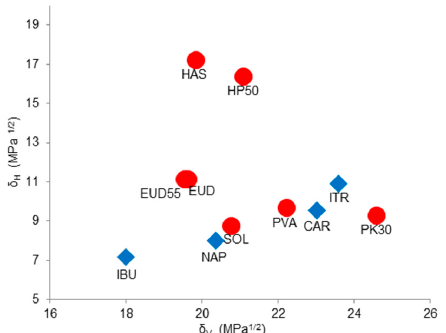
Figure 4. Specific locations of drugs (blue) and polymers (red) within Bagley diagram.